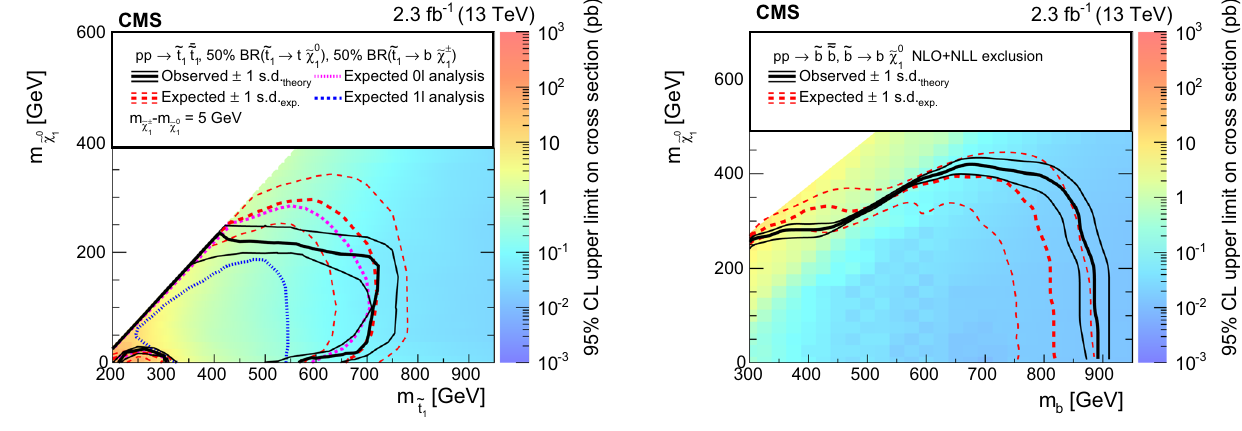
Fig. 10 Exclusion limits at 95% CL for direct bottom squark pair pro- Fig. 8 Exclusionlimitsat95%CLfordirecttopsquarkpairproduction duction with decay (cid:2) b 1 → b (cid:2) χ 0 . The interpretation is performed in the assuming equal branching fractions for the decays (cid:2) t 1 → t ( ∗ ) (cid:2) χ 0 and 1 1 (cid:2) t two-dimensional space of m (cid:2) vs. m (cid:2) χ 0 using the results of the bottom → b (cid:2) χ ± . The interpretation is performed in the two-dimensional b 1 1 1 1 squark analysis (Sect. 6). The caption of Fig. 7 explains the use of lines space of m (cid:2) t vs. m (cid:2) χ 0 . The chargino is considered to be nearly mass- 1 1 and colors in detail = m + 5GeV). The caption of Fig. 7 degenerate with the LSP ( m (cid:2) χ ± (cid:2) χ 0 1 1 explains the use of lines and colors in detail is observed above the expected standard model background, and exclusion limits are set at 95% confidence level in the context of simplified models of direct top and bottom squark pair production. Limits for top squark masses of 830 GeV are established for a massless LSP, and for LSP masses up to 260 GeV for a 675 GeV top squark mass, when all top squarks are assumed to decay to a top quark and an LSP. When the top squarks can also decay to a bottom quark and a chargino, this reach is reduced. Assuming a mass splitting between the top squark and the LSP close to 10 GeV, and top squarks that decay to a charm quark and an LSP, top squark mass limits up to 240 GeV are established. Finally, bottom squark mass limits up to 890 GeV are established for small LSP masses. The results extend the reach with respect to pre- vious limits obtained from LHC Run 1 data in most of the Fig. 9 Exclusionlimitsat95%CLfordirecttopsquarkpairproduction parameter with decay (cid:2) t 1 → c (cid:2) χ 0 using the compressed SRs of the bottom squark 1 analysis (Sect. 6). The interpretation is done in the two-dimensional space of m (cid:2) t vs. m (cid:2) χ 0 . The caption of Fig. 7 explains the use of lines and 1 1 colors in detail